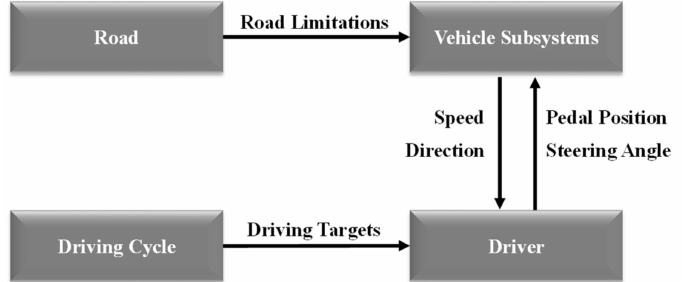
Figure 2. The complete vehicle model consists of the modeling of vehicle subsystems, driver, road, and driving